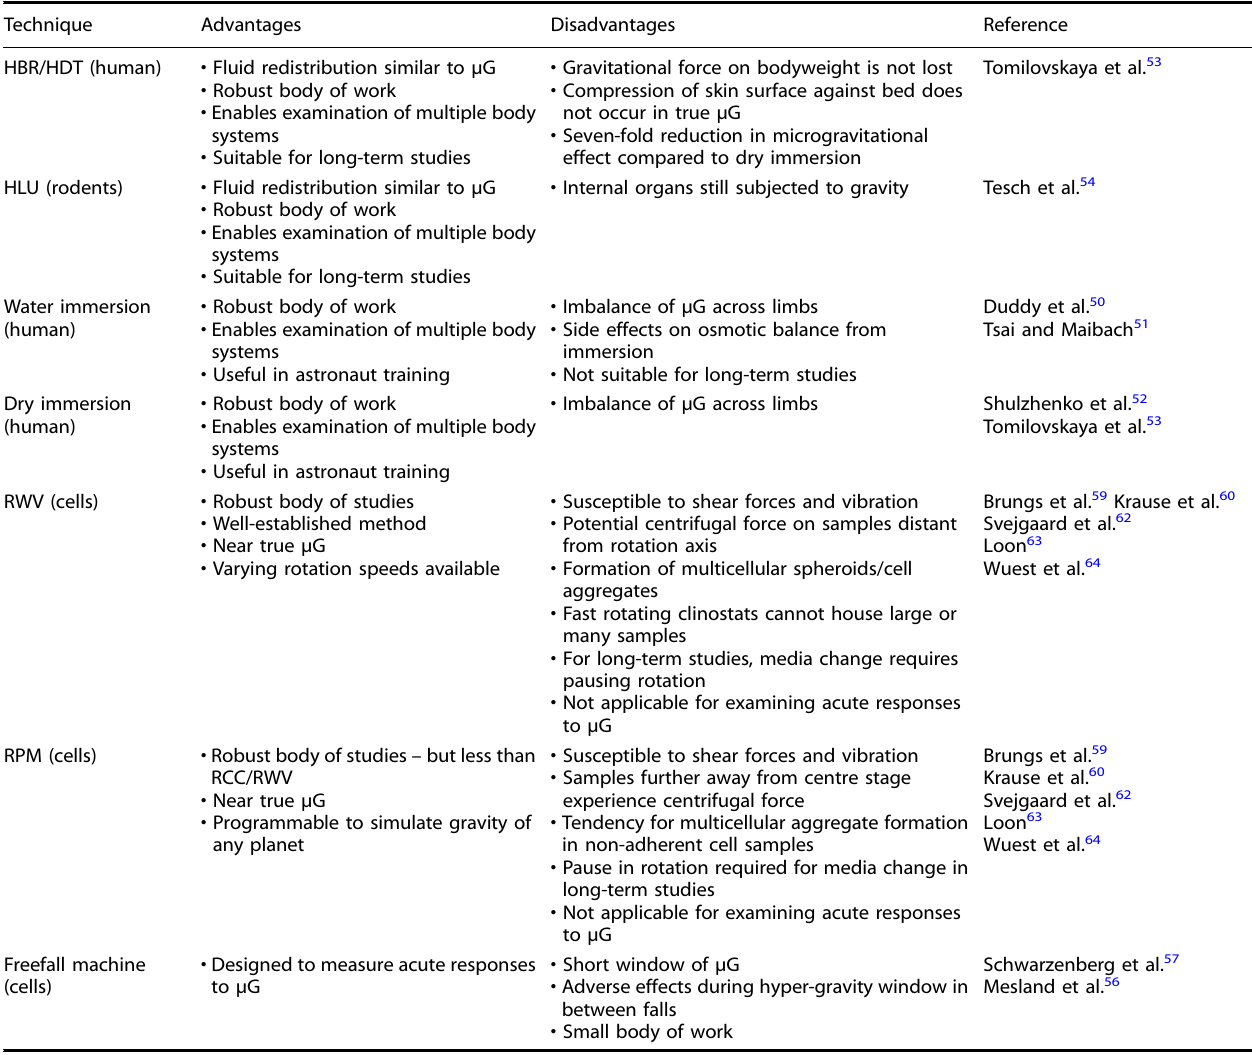
Table 2. Advantages and disadvantages of microgravity simulation techniques. Technique